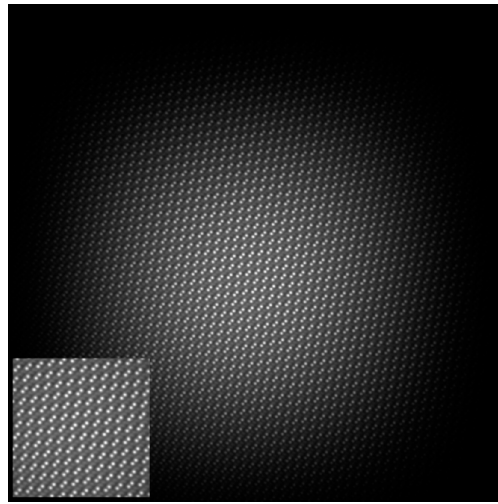
Figure 7. [110]-projected ZnSe/GaAs atomic potential (at higher magnification in the inset) averaged in the whole illuminated area corresponding to the HRTEM image of Figure 4.